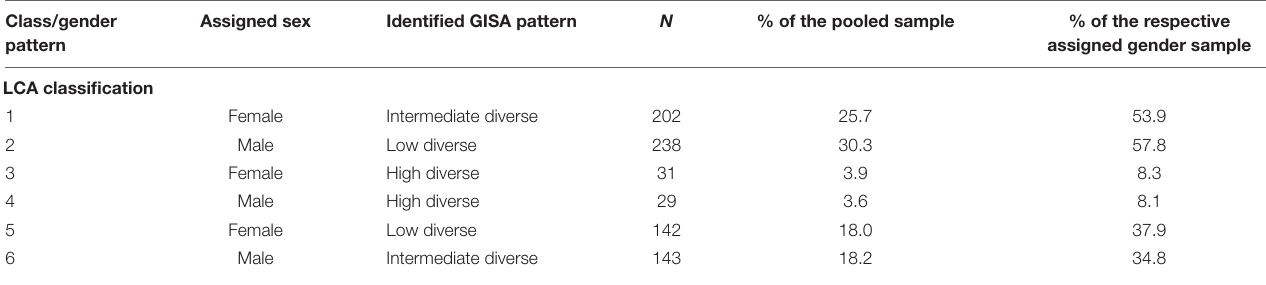
TABLE 3 | Latent class analysis classification by assigned sex and identified GISA pattern for the chosen LCA-multigroup 3-class solution with all 11 indicators. Class/gender